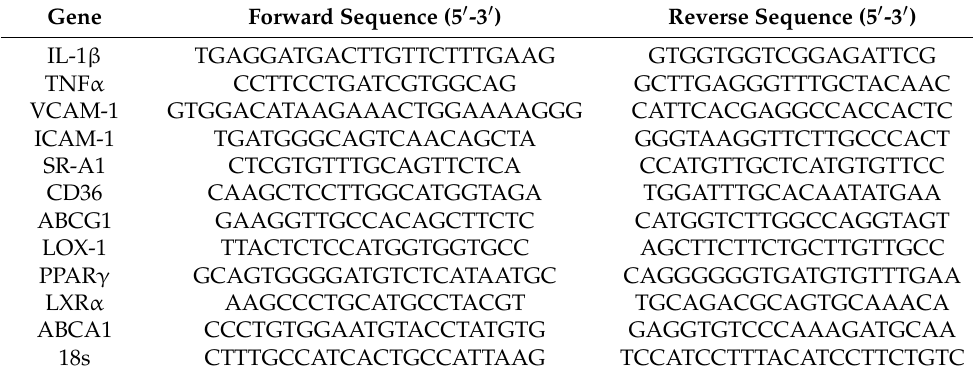
Table 1. Primer pair sequences used in the